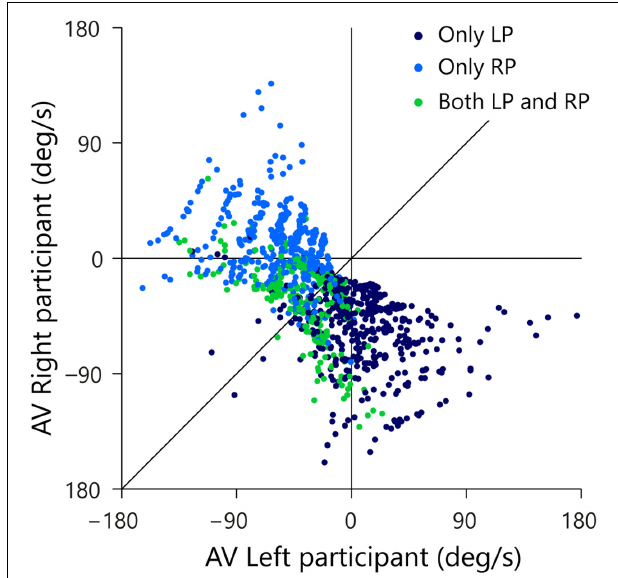
FIGURE 7 | Rate of change of β RP (AV-RP) as a function of rate of change of β LP (AV-LP) at the moment of first participant movement initiation. Trials with only LP initiation are indicated by dark blue dots, trials with only RP initiation by light blue dots, and trials with both LP and RP initiation by green dots. The thin vertical and horizontal lines mark zero AV for the LP and RP, respectively. The thin diagonal line marks AV-LP =